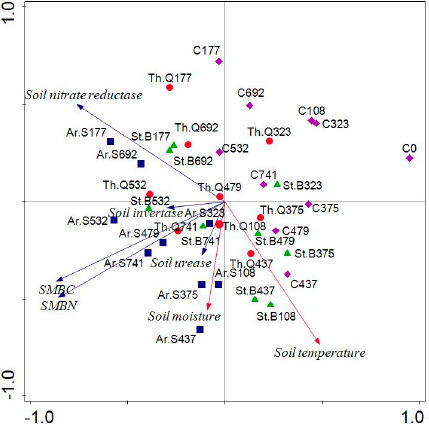
Figure 4. Principal component analysis of soil moisture and temperature and microbial